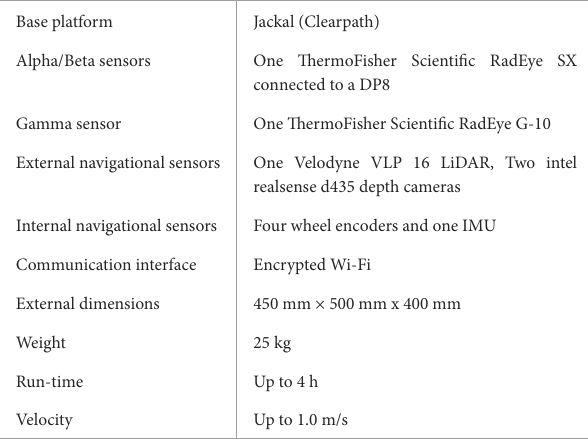
• A full hardware redesign including a control base-station